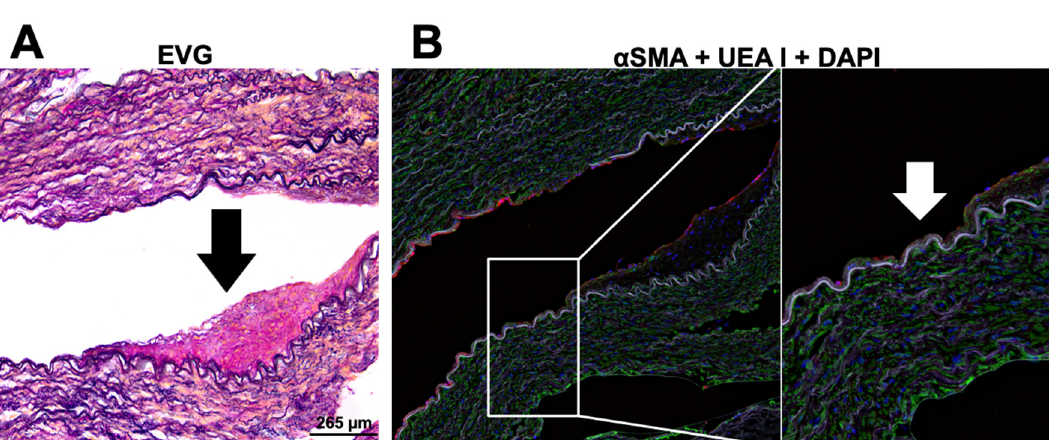
Figure 6. Photomicrographs of diseased human internal mammary artery (IMA) from a coronary artery bypass graft (CABG) patient. Representative serial sections of IMA stained with ( A ) Elastic Van Gieson (EVG), ( B ) alpha smooth muscle actin ( α -sma) (green fluorescence), Ulex Europaeus Agglutinin I (UEA I) (red fluorescence) and DAPI (detection of nuclei) (blue fluorescence). Increased matrix deposition of elastin on the elastic lamina was indicated by a black arrow. Magnification ×10. Scale bar = 265 μ m. The representative absence of an intact endothelial cell lining, as shown by the lack of red fluorescence, is indicated by a white arrow (insert; magnification ×20). These are repre- sentative images of similar observations in five patients with 10 sections from each patient.